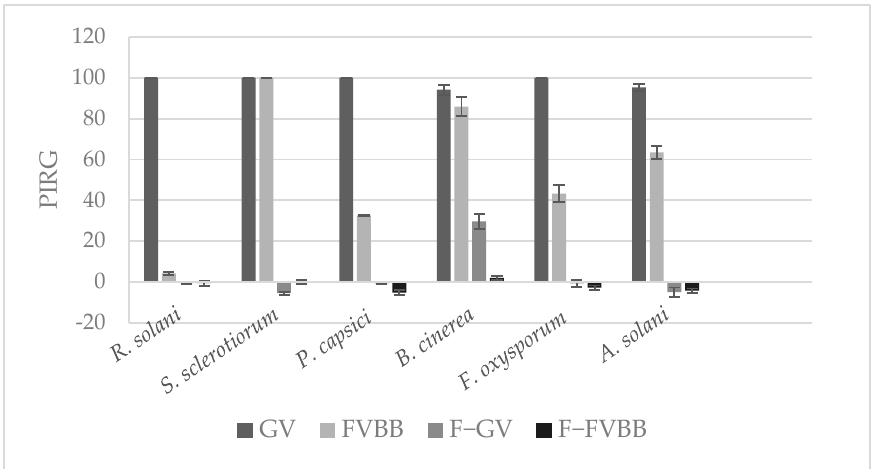
Figure 3. The effects of filtered (F-GV and F-FVBB) and non-filtered (GV and FVBB) frass extracts from the two diets on mycelial growth of Rhizoctonia solani , Sclerotinia sclerotiorum , Phytophthora capsici , Botrytis cinerea , Fusarium oxysporum , and Alternaria solani . Each value represents the mean of 3 replicates ± standard error. PIRG = percent inhibition of radial growth.